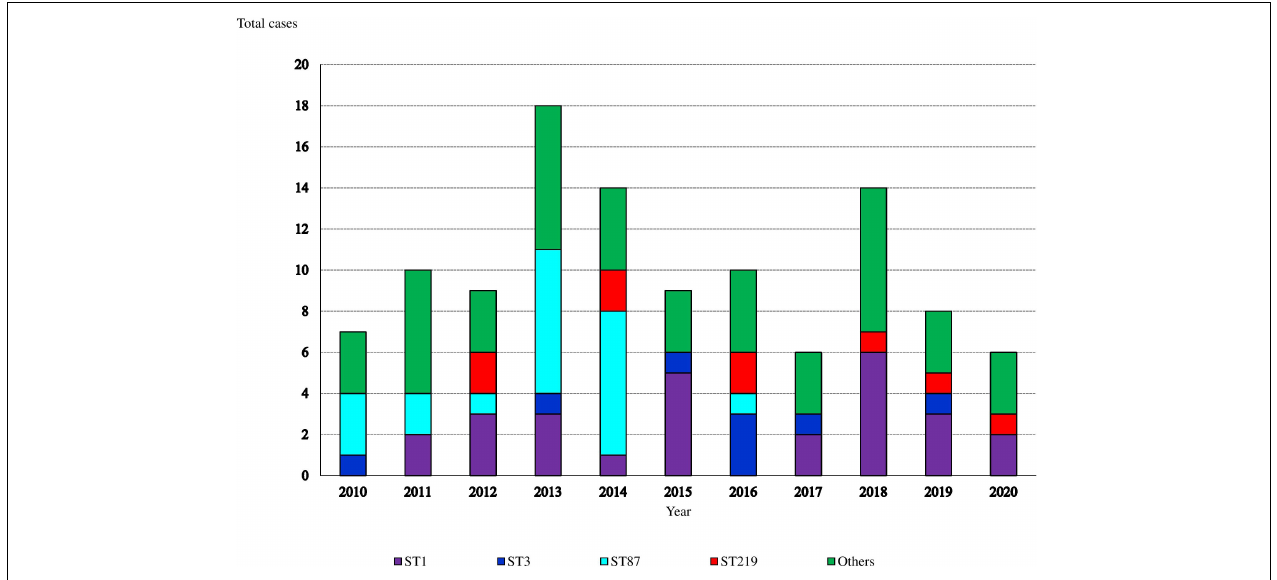
FIGURE 1 | Annual distribution of sequence-types (STs) causing invasive listeriosis (such as pregnancy and non-pregnancy associated